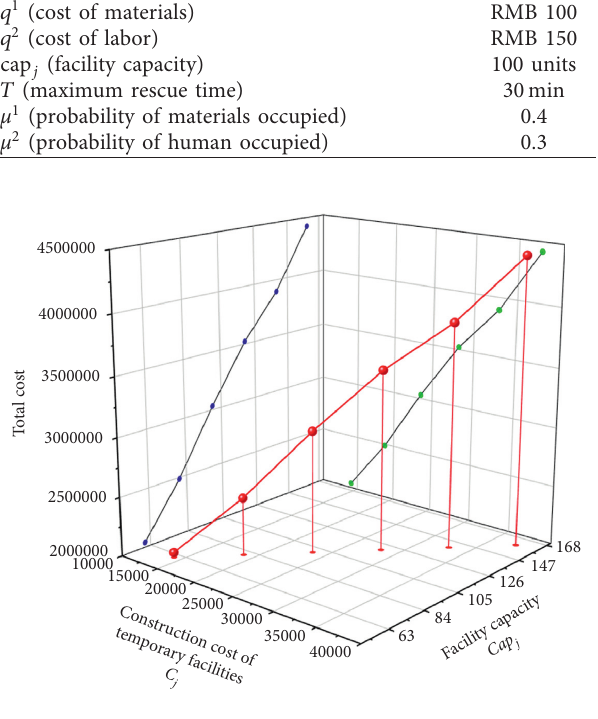
Figure 6: The graph of total cost, C